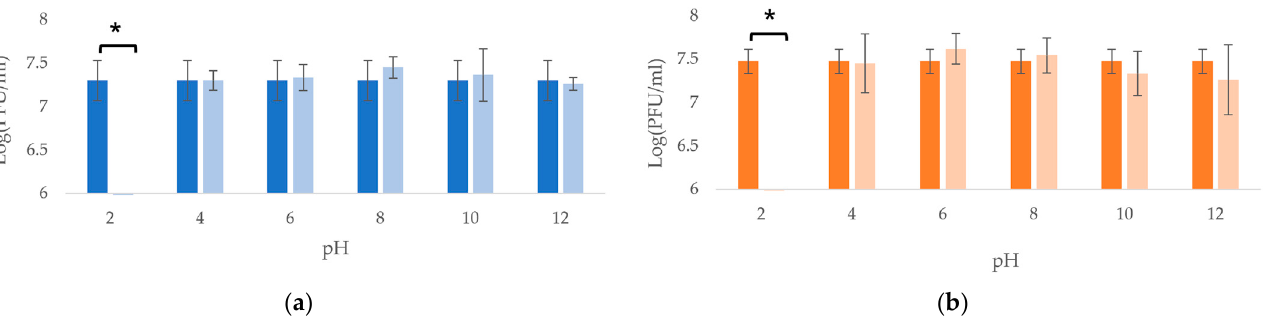
Figure 3. pH stability of the bacteriophages ( a ) vB_KpnP_K3-ULINTkp1 and ( b ) vB_KpnP_K3- ULINTkp2 after 1 h of pH treatment at 25 °C. The mean value of 3 titrations (± σ ) is represented and the concentration measured before testing is represented with dark bars. p -value (*) ≤ 0.05.